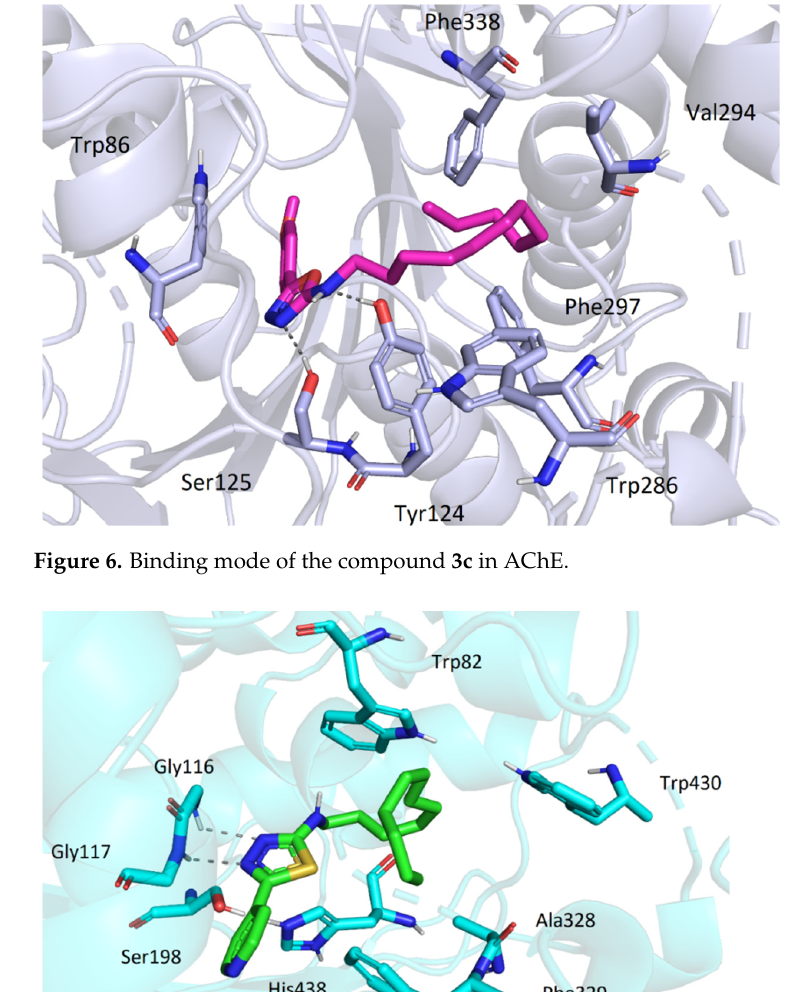
Figure 8. The conformation of 3s in the active site of BChE. 3. Materials and Methods 3.1. Chemistry 3.1.1. General All chemicals for synthesis and analysis were purchased from Merck KGaA (Darm- stadt, Germany), Penta Chemicals Unlimited (Prague, Czech Republic), Avantor (St ř íbrná Skalice, Czech Republic), and Lach-Ner (Neratovice, Czech Republic) and were used as received. The structures of the prepared substances were confirmed by 1 H NMR and 13 C NMR spectroscopy analysis. NMR spectra were measured in dimethylsulfoxide (DMSO-